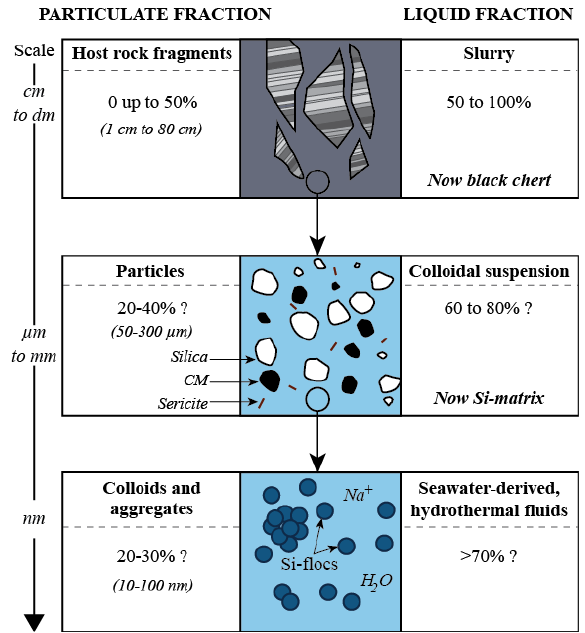
Figure 14. Sketches showing our interpretation of the chert prop- erties at the time of injection and at various scales. From top to bottom, the chert consistently contained a “particulate” and a “liq- uid” fraction in varying proportions. Percentages are approximate, i.e. based on thin section observations and taking into account the dewatering and compaction of cherts during induration. The col- loidal fraction (bottom) is responsible of the rapid viscosity varia- tions through